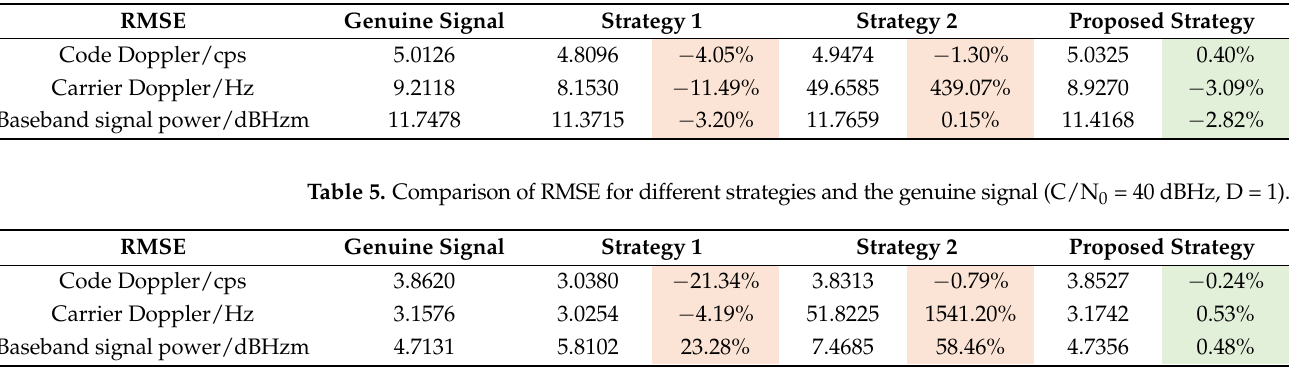
Table 4. Comparison of RMSE for different strategies and the genuine signal (C/N 0 = 30 dBHz, D = 1).